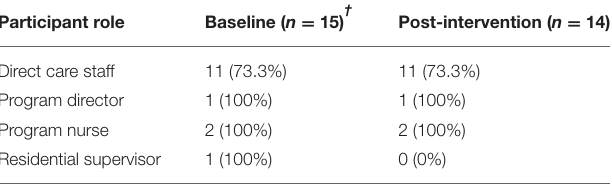
TABLE 1 | Response rate by participant role.